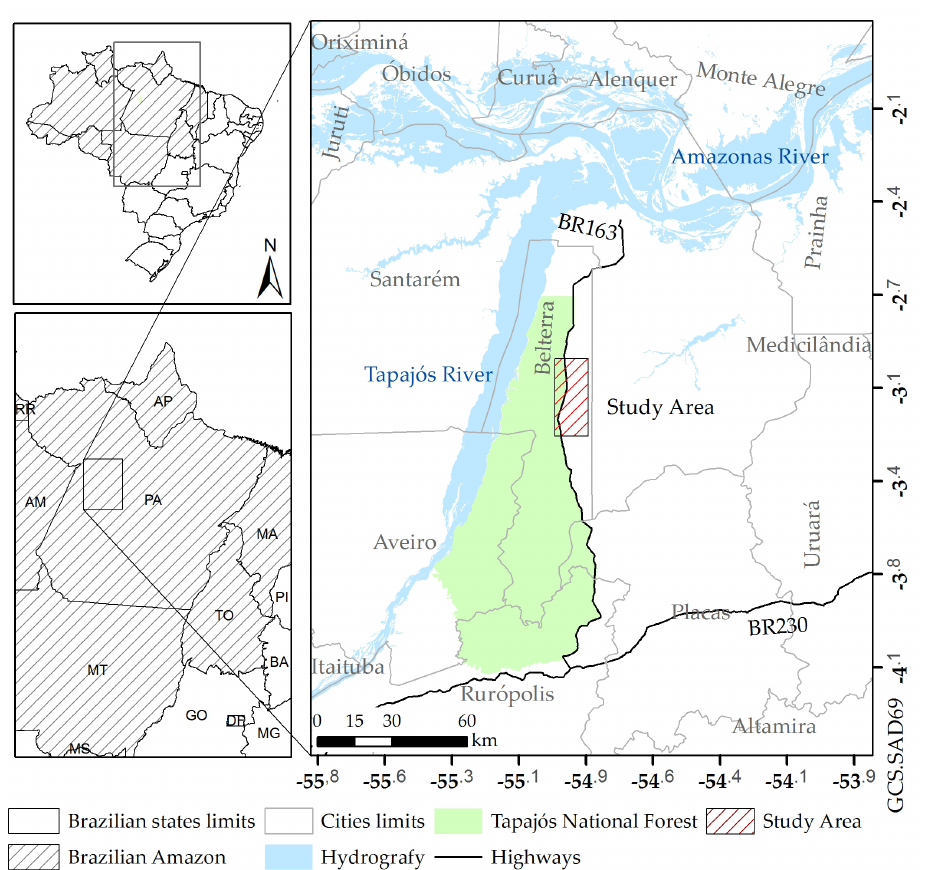
Figure 1. Study area, with geographical